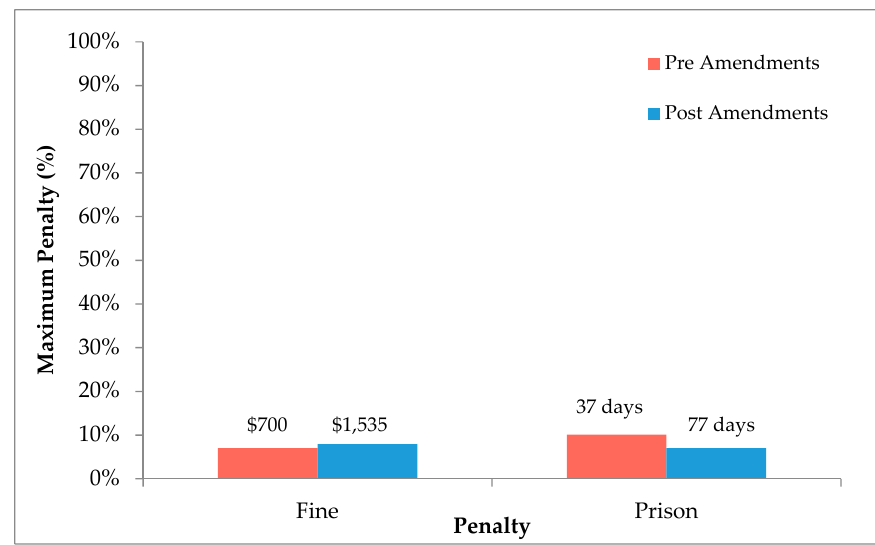
Figure 4. Comparison of the penalties imposed relative to the maximum penalty under section 13 of the AWA before, and after the 2008 amendments. Only prison sentences ( n = 23) and fines ( n = 130) were considered, as they were the subjects of the 2008 amendments. The average sentences are listed above their corresponding percentage of the maximum penalty for both pre-amendment ( n = 62) and post-amendment ( n = 91) data. Error bars are not included, as the data are presented as percentages.